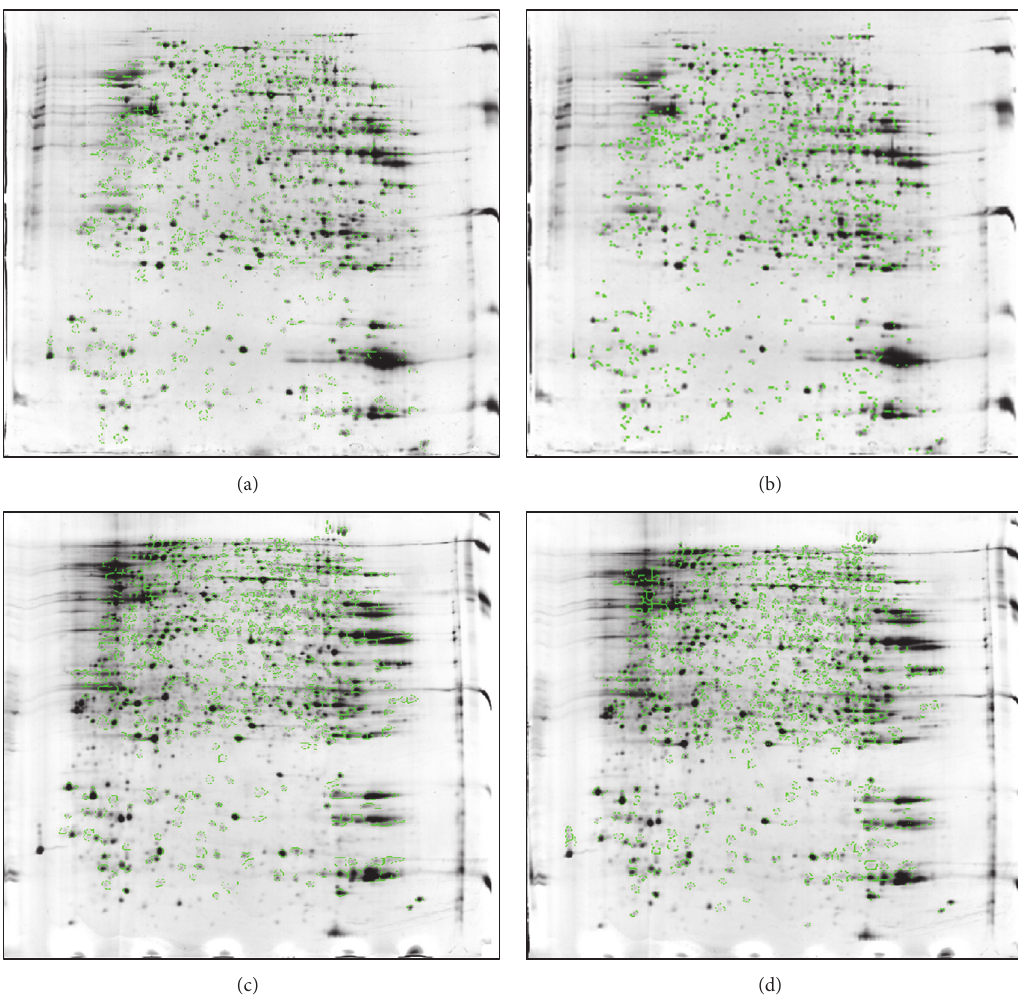
Figure 2: Two-dimensional gel electropherograms obtained from hypothalamus and hippocampi tissues, analysed in pairs. (a) Image overlay of the hypothalamus samples from the control group and the model group. (b) Image overlay of the hypothalamus samples from the control group and the group administered with Baixiangdan. (c) Image overlay of the hippocampi samples from the control group and the model group. (d) Image overlay of the hypothalamus samples from the control group and the group administered with